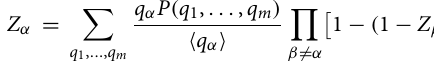
10 8 and m 3 layers of = = � � c , where � P ( 1 ) . In the limit of very small = − = 0 = 1 / 2 δ . Each point is averaged over 10 e − c = = +